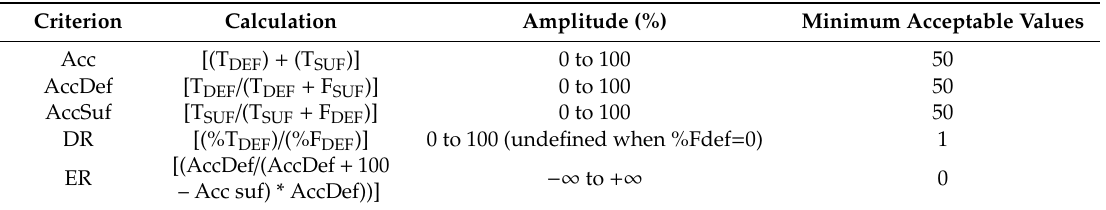
Table 2. Measures of accuracy and acceptable values to assess the nutritional status of Eucalyptus spp. rooted cuttings using the CL, DRIS and CND